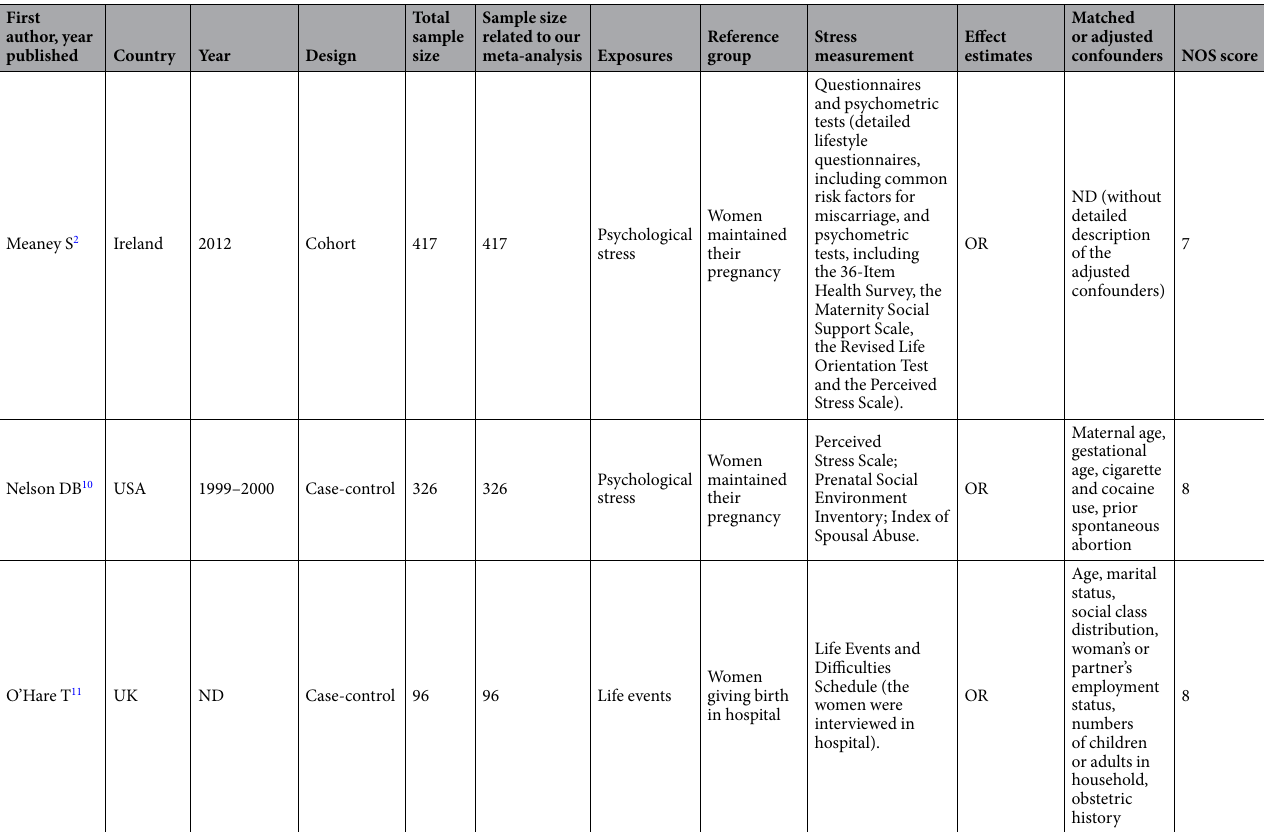
Perceived Stress Scale; Prenatal Social Environment Inventory; Index of Spousal Abuse.